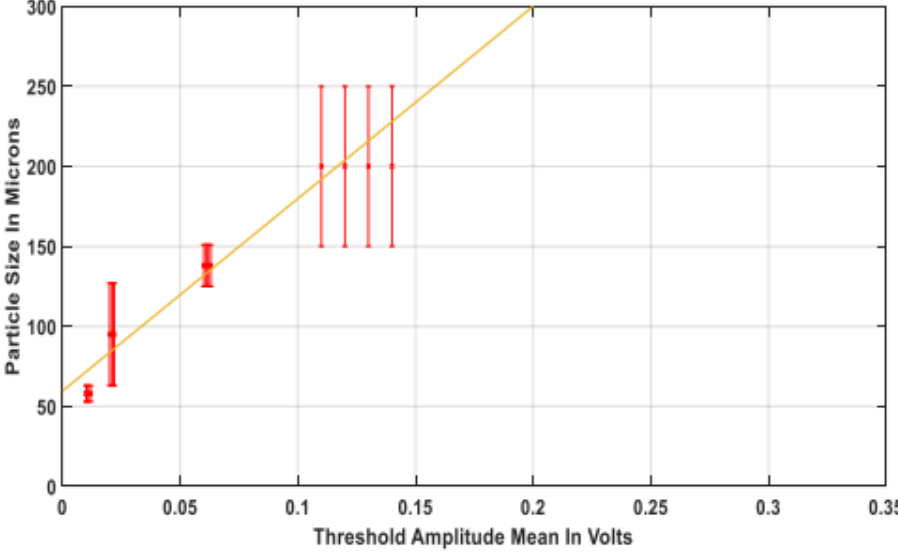
Figure 11. Resulting regression plot for optimal threshold region for polyethylene material [27].